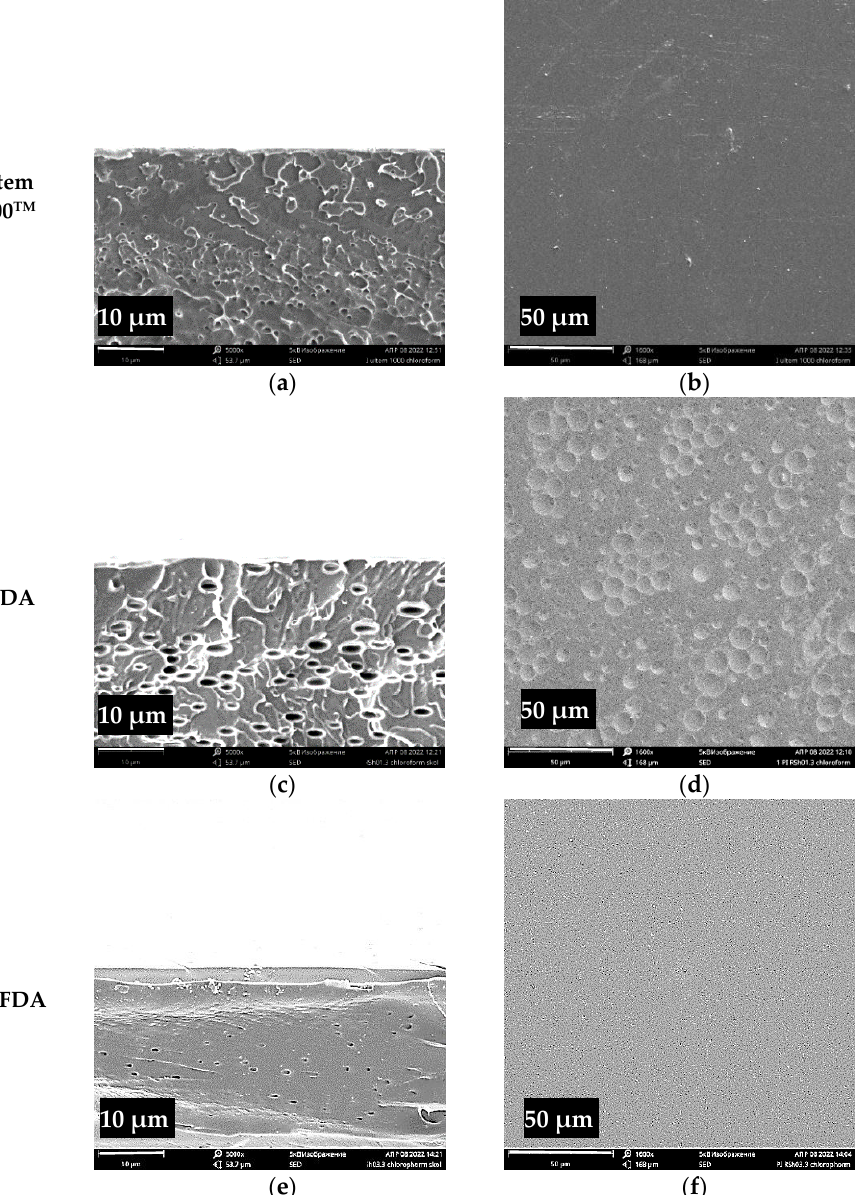
Figure 11. SEM images of the cross-section ( a , c , e ) and surface of the selective layer ( b , d , f ) of mem- branes based on Ultem 1000™ , PI-DA and PI-6FDA.